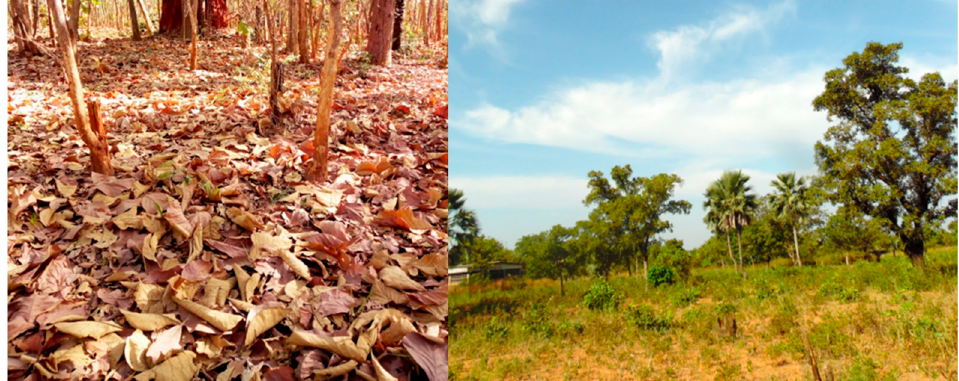
Figure 2. View of the two sites: Dinderesso ( left ) and Nasso ( right ).